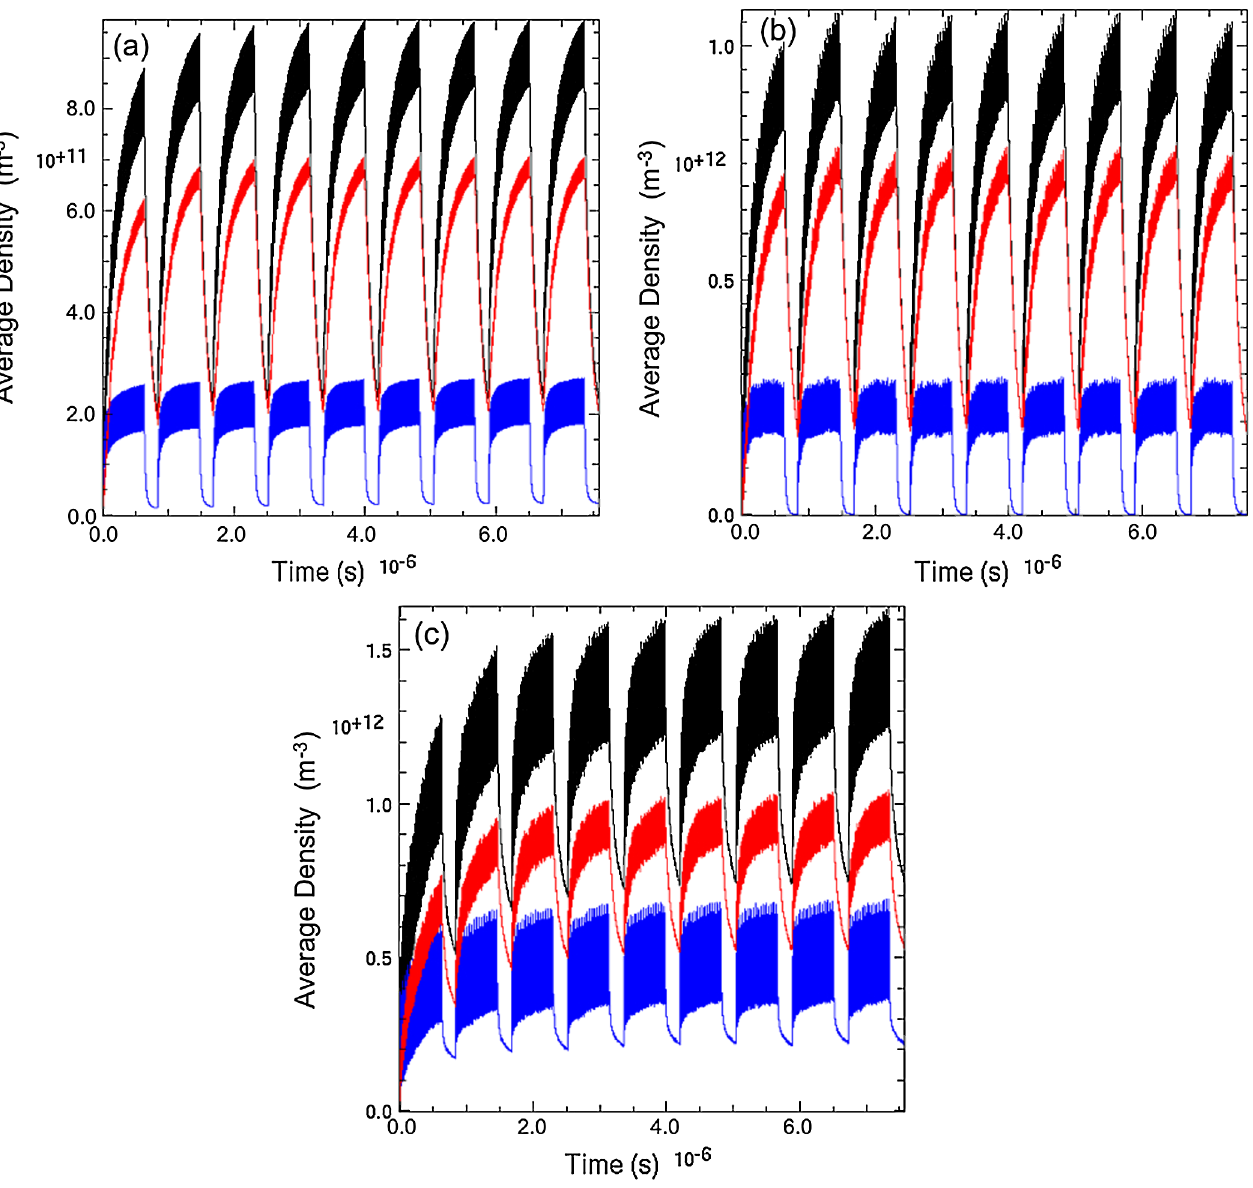
FIG. 13. Average electron density vs time created by nine 45-bunch trains separated by 15-bunch gaps. The lowest curve is photoelectrons, the middle is secondaries, and the top curve is the total. (a) Whole wiggler period, (b) averaged over 6.24 mm in z centered at a position of maximum B y , (c) averaged over 6.24 mm in z centered at a field